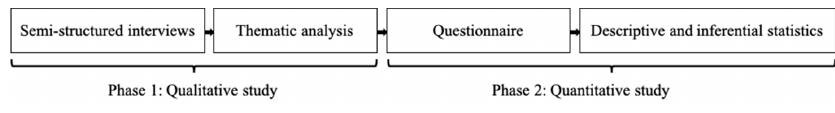
Figure 1. The methodology used in this study.